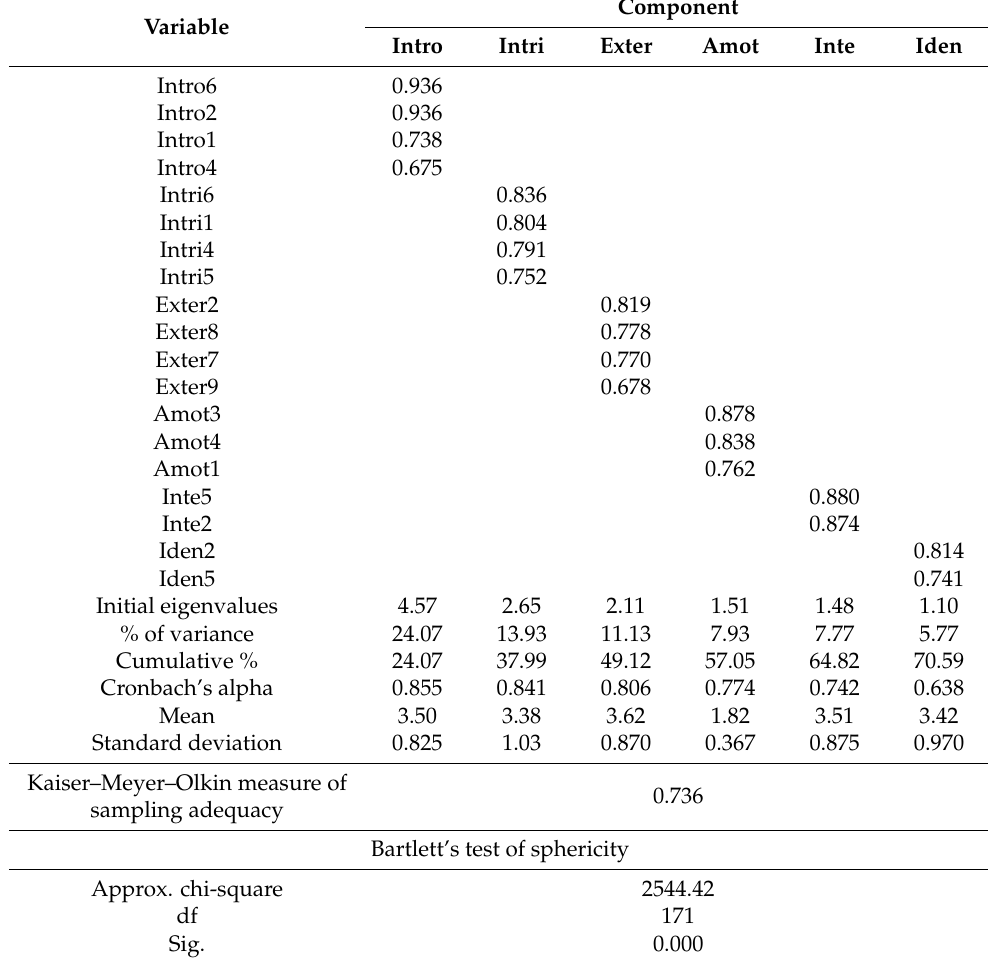
Table 3. Exploratory factor analysis and reliability of motivational